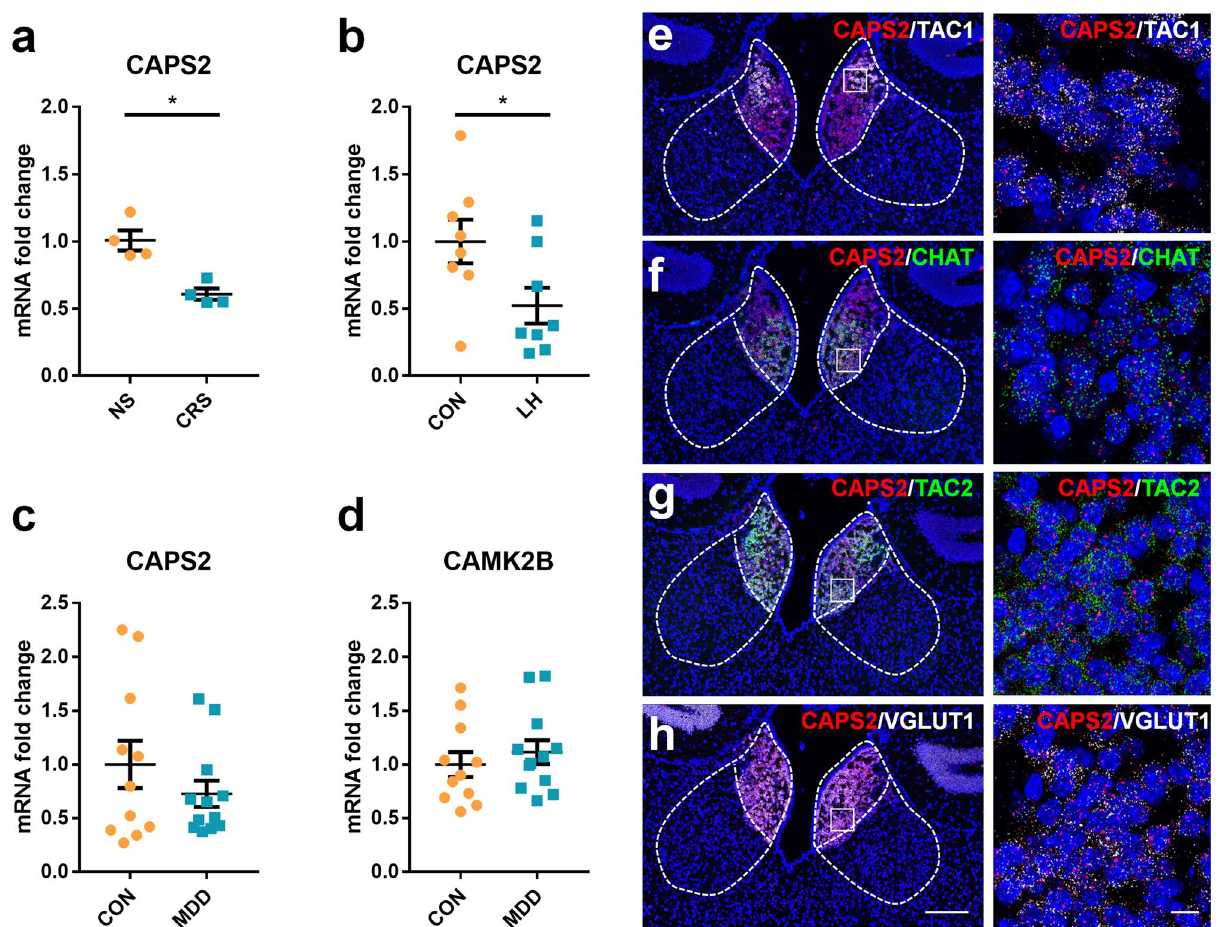
Figure 1. CAPS2 gene expression in the animal models of depression, MDD patients, and identification of CAPS2 expressing cells. ( a–d ) qRT-PCR analysis showed that the CAPS2 mRNA expression level decreased in the habenula of rats exposed to CRS ( a ), mice exposed to electric shock ( b ). CAPS2 mRNA expression showed a tendency to decrease in the habenula of MDD patients who died by suicide ( c and d ). CAMK2B levels did not show any difference between the two groups. The relative abundances of mRNA were normalized to the amount of GAPDH using the comparative threshold cycle method. ( e–h ) Photomicrographs of the double-labeled fluorescent in situ hybridization for CAPS2, TAC1, TAC2, CHAT, and VGLUT1. Antisense riboprobe-labeled were for CAPS2/TAC1 ( e ), CAPS2/CHAT ( f ), CAPS2/TAC2 ( g ), and CAPS2/VGLUT1 ( h ). These genes were co-expressed in the MHb. Data represent mean ± SEM, * P < 0.05 ( a , NS, n = 4; CRS, n = 4 rats; P = 0.029, Mann– Whitney U -test; b , CON, n = 8; LH, n = 8 mice; P = 0.038, c, d , CON, n = 11; MDD, n = 12 subjects; CAPS2: P = 0.279; CAMK2B: P = 0.483; Student’s t -test; Scale bars, 200 μm; 10 μm in the magnified pellets and the amount of food consumed after the test did not differ between the groups. As CAPS2 KO mice have manifested autism-like behavior 8 , we next examined the social interaction in the MHb CAPS2 knockdown mice. There was also no significant difference in the social interaction ratio between control and MHb CAPS2 knockdown mice (Supplementary Figure S4). Together, these data suggest that selective reduction of MHb CAPS2 protein induces despair-like behavior, but not anxiety, anhedonia, and social dysfunction. MHb CAPS2 knockdown leads to accumulation of presynaptic dense‑core vesicles in the IPN. It is known that the major output of the MHb connects to the IPN through fasciculus retroflexus 15,26 . Since CAPS2 is well-known in regulating DCV exocytosis, we examined the IPN to observe the ultrastructural effect of MHb CAPS2 knockdown using transmission electron microscopy. Areas of presynaptic bouton and length of postsynaptic density did not differ between the two groups (n = 4 for each group; Mann–Whitney U -test; area of presynaptic bouton: 0.91 ± 0.25 μm 2 vs. 1.07 ± 0.13 μm 2 , P = 0.486; postsynaptic density length: